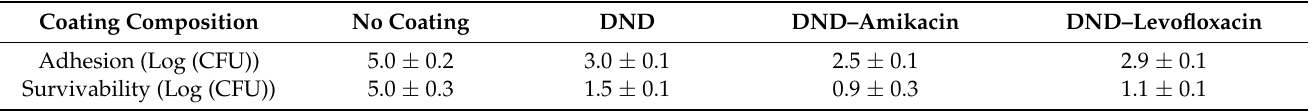
Table 3. The adhesion index and the survival index of Staphylococcus aureus calculated according to the results of bactericidal efficacy for the DND, DND–Levofloxacin and